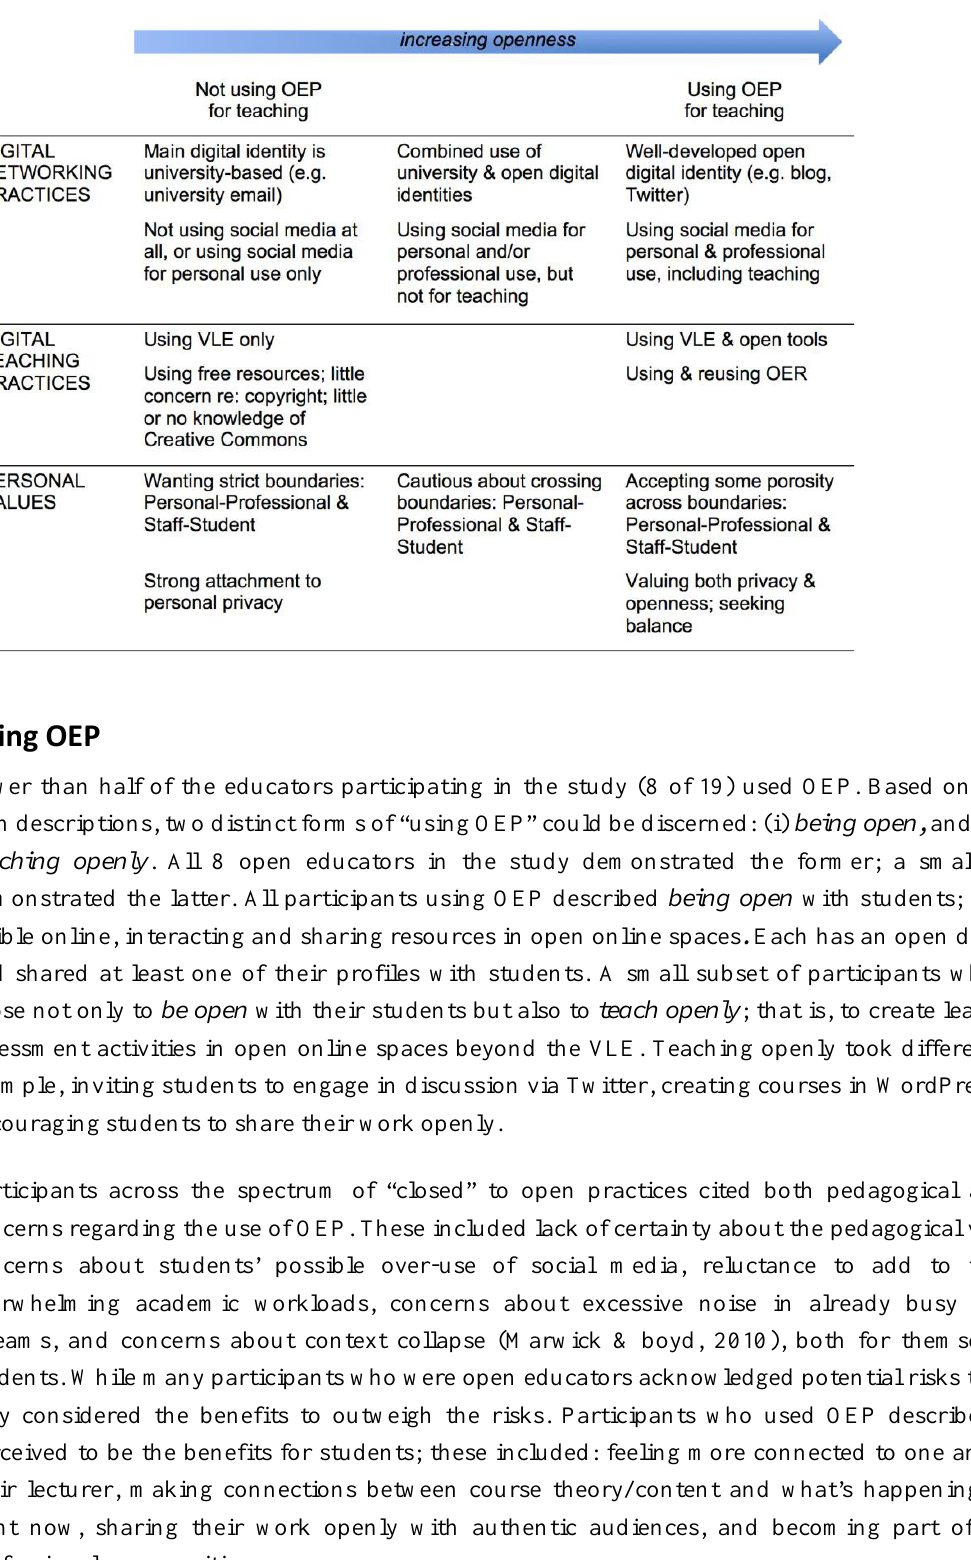
Summary of Participants’ Digital and Pedagogical Practices and Values on a Continuum of Increasing